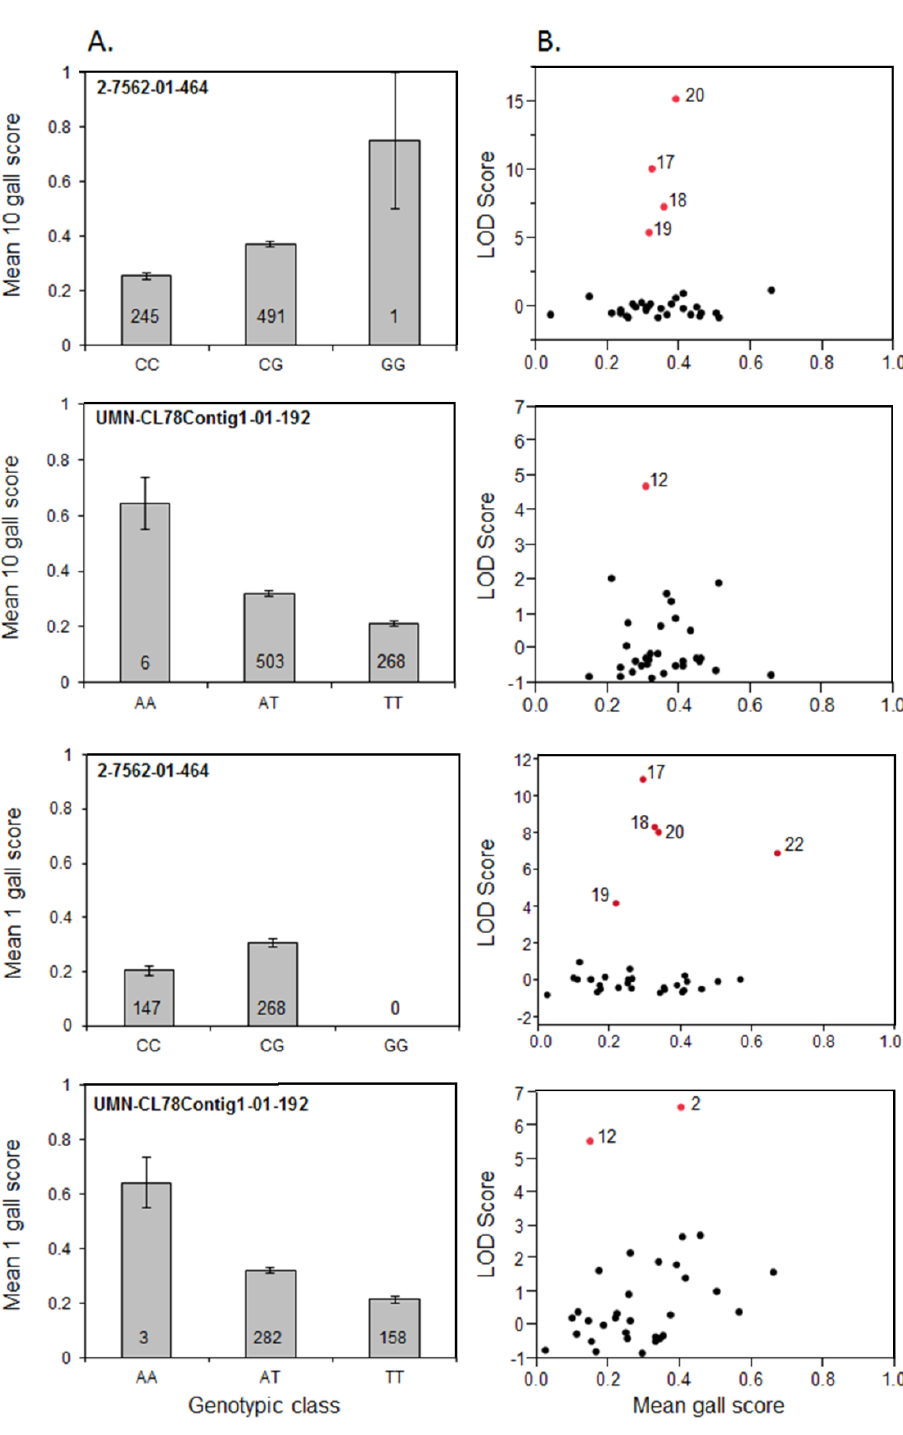
Figure 3. ( A ) Mean gall scores for 10 gall (top) and one gall (bottom) inoculum across genotypic classes for two significant SNPs for gall score. Error bars correspond to standard errors of the mean and the numbers within the graphs correspond to the number of clones for each genotypic class in the CCLONES population; ( B ) Single marker regression results showing LOD scores vs. mean gall score for 10 gall (or one gall) inoculum by parent for the two significant SNPs shown in A. Each point within the plot corresponds to a single parent. Red dots show parents with LOD scores above 3 with their corresponding identification number, while black dots show parents with LOD scores